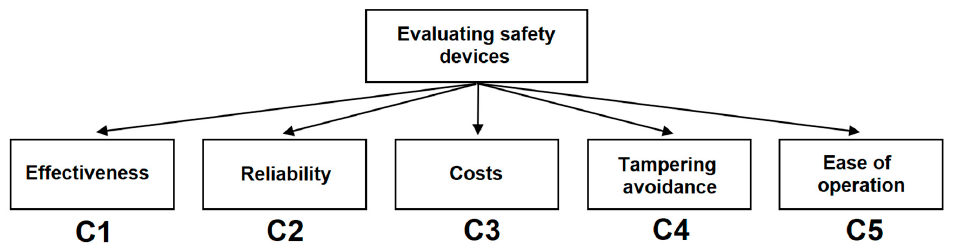
Figure 4. Criteria proposed for evaluation.